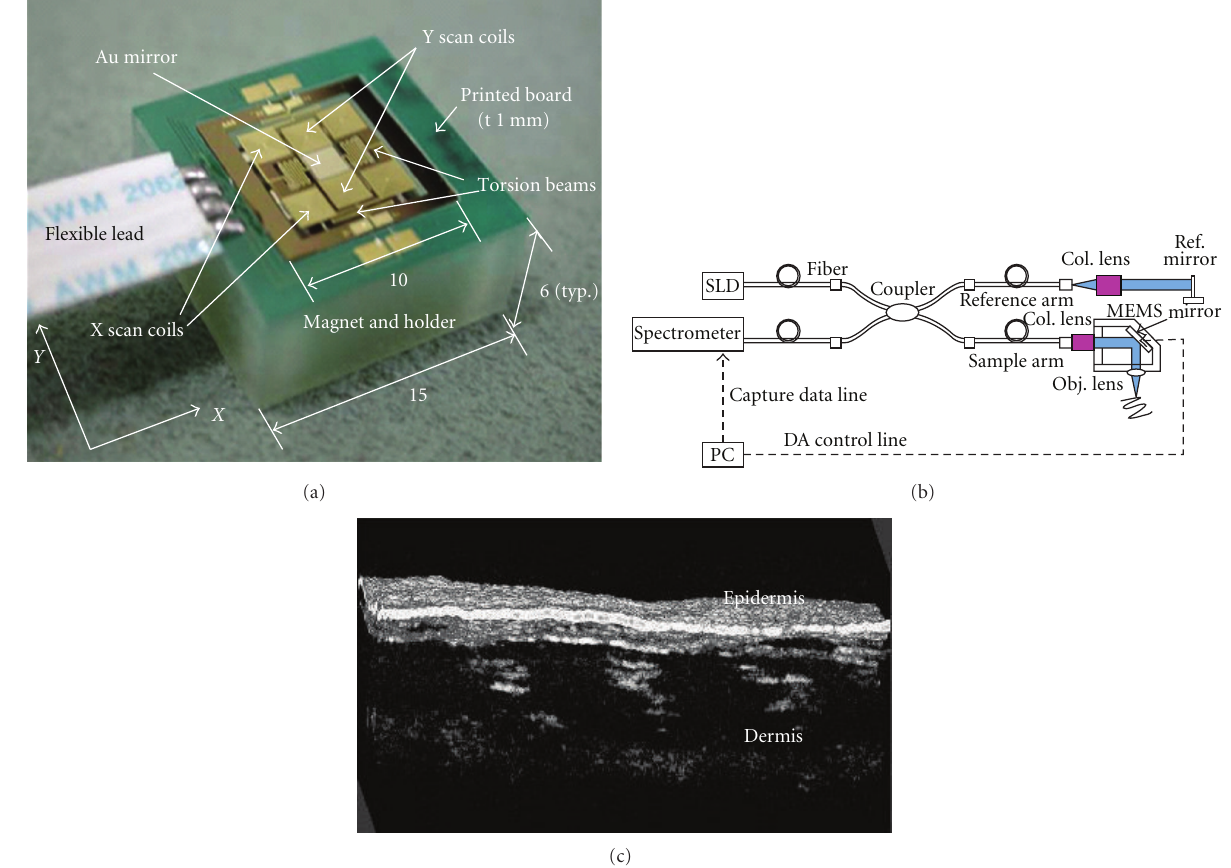
Figure 6: Electromagnetic MEMS OCT from Yamagata Research Institute of Technology, Japan. (a) MEMS mirror module, (b) MEMS probe in OCT system, (c) 3D image of human finger tip. All rights reserved by the Institute of Electrical Engineers of Japan.